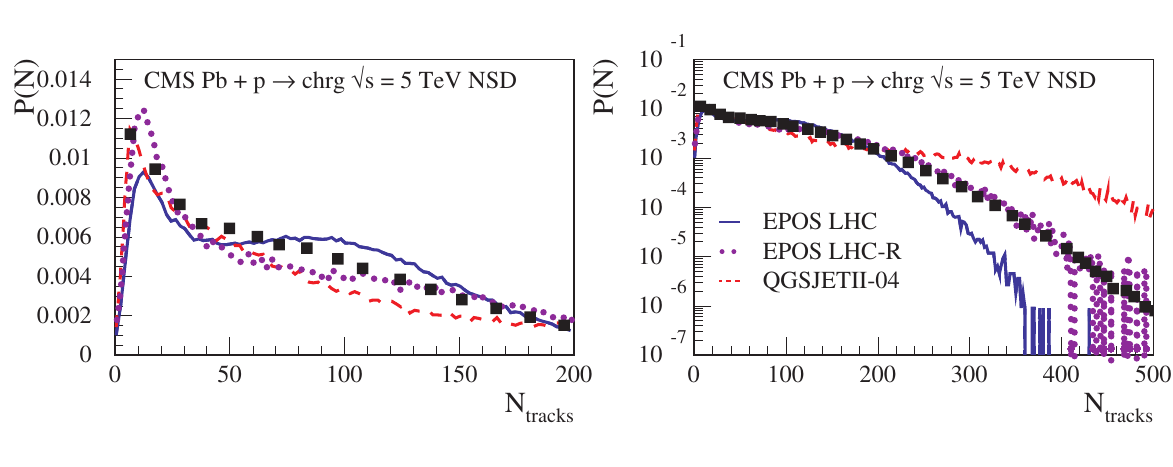
Figure 2. Multiplicity distribution of Pb-p collisions at 5 TeV with E pos LHC-R (dotted line), E pos LHC (full line), QGSJ et II.04 (dashed line) simulations using a Non-Single-Di ff ractive (NSD) experimental trigger. Data points are from [30] corrected for acceptance and e ffi ciency. On the left-hand side, with a linear scale for the y-axis and with a logarithmic scale on the right-hand